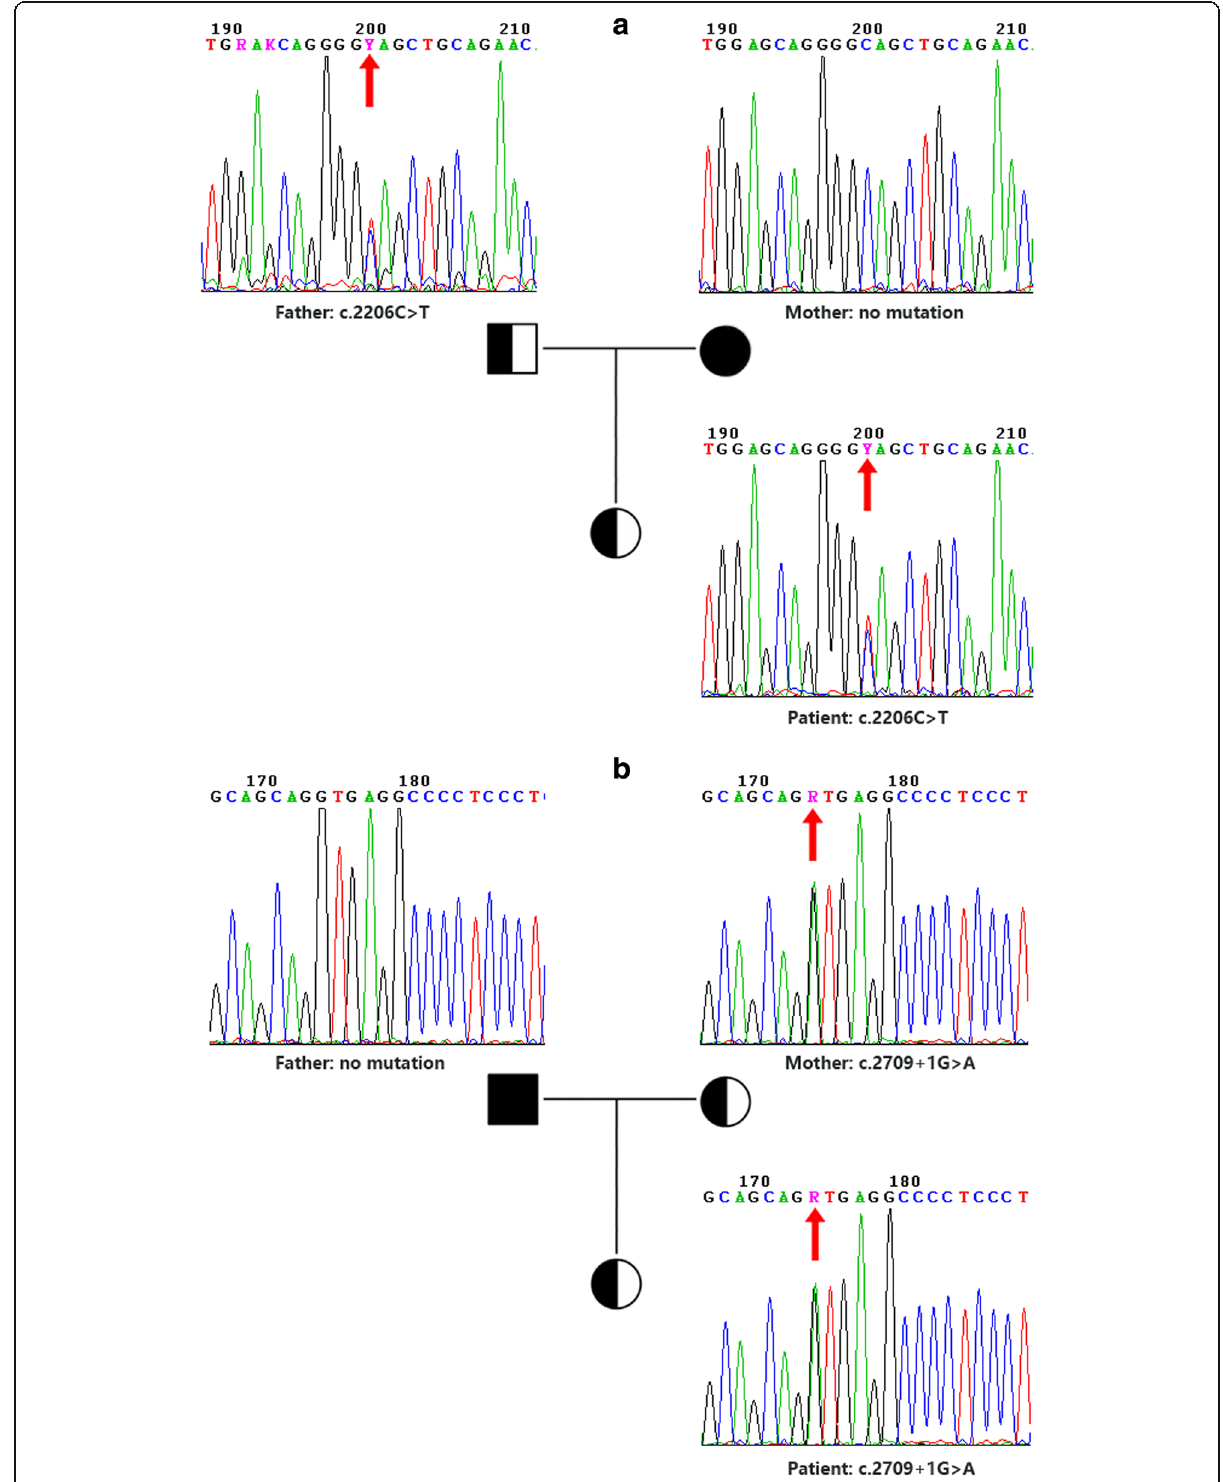
Fig. 2 Two-generation pedigree analysis for two heterozygous mutations in the UNC13D gene. a Novel nonsense mutation (c.2206C > T) in UNC13D -exon24; b Reported splicing mutation (c.2709 + 1G > A) in UNC13D -exon28. The position of the mutation is marked with a red arrow. The results showed that the nonsense mutation was inherited from father and the splicing mutation was inherited from mother. Zygosity was indicated by letters of degenerate bases (Y: C/T, R: